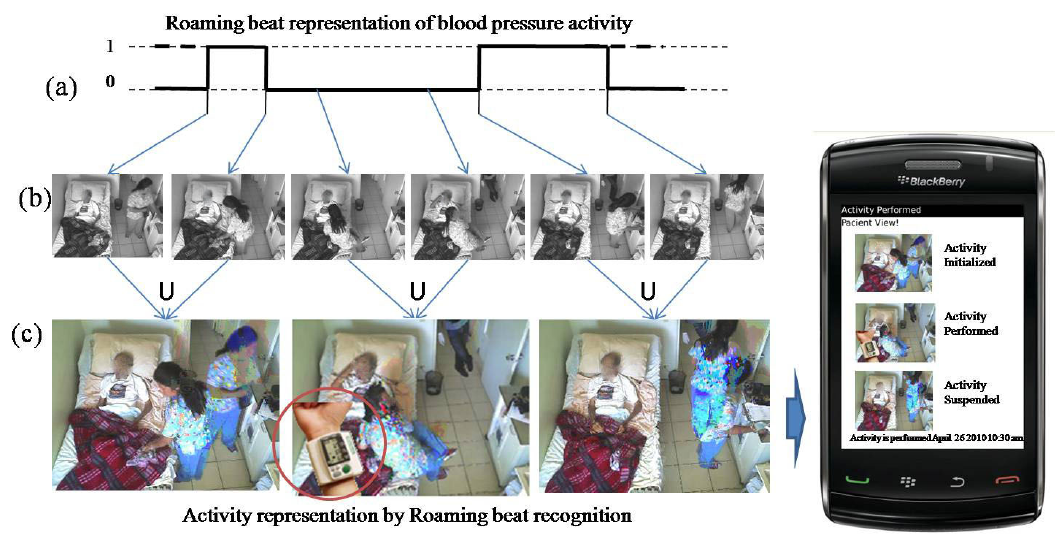
Figure 11. Sending roaming beat representation to a mobile device ( a ) Roaming beat representation of blood pressure activity; ( b ) Images acquired using indexes of a video sequence; ( c ) Joining two images, additional